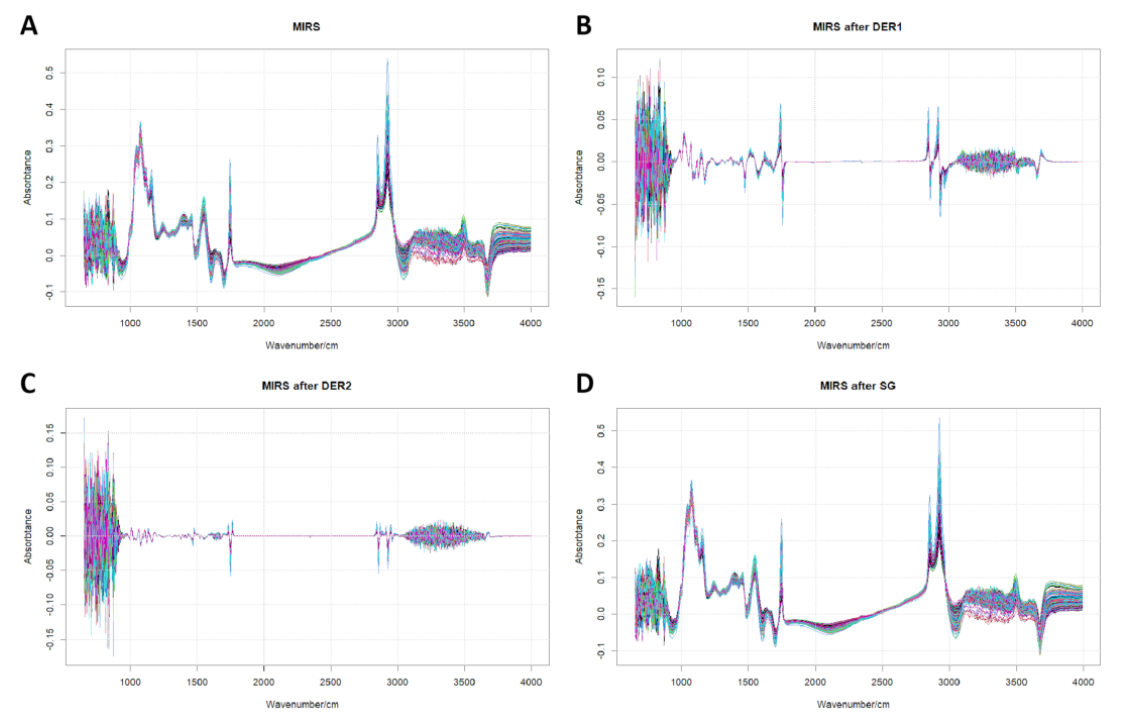
Figure 1. MIRS after DER1, DER2, and SG pre-processing algorithms. Note: MIRS, DER1, DER2, and SG indicate mid-infrared spectrum, first-order derivative, second-order derivative, and Savitzky–Golsy convolution smoothing, respectively.